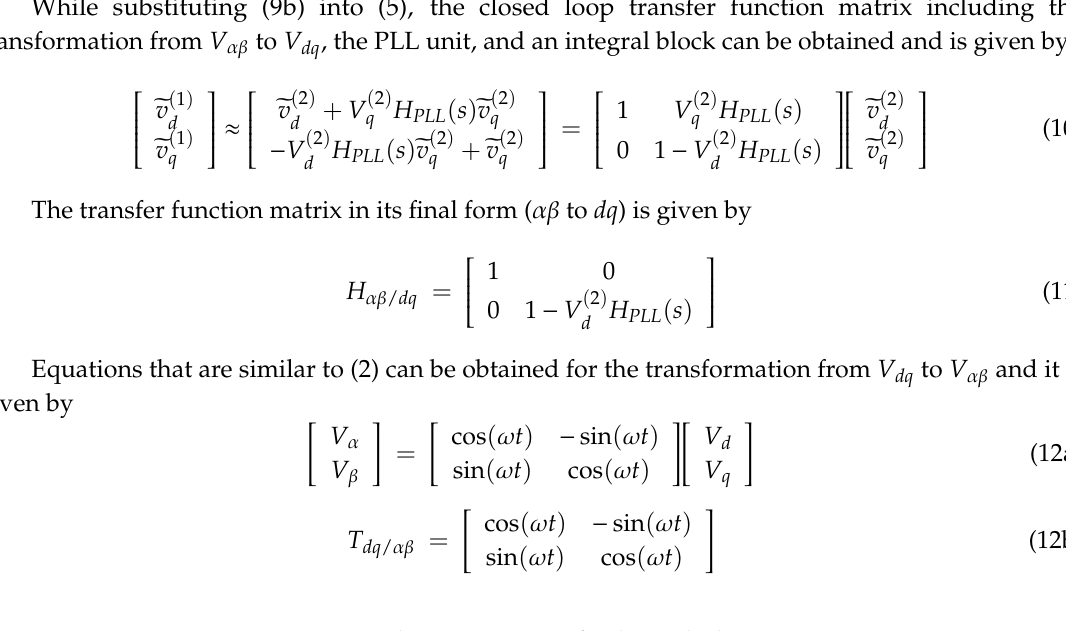
Table 1. Simulation parameters for the studied